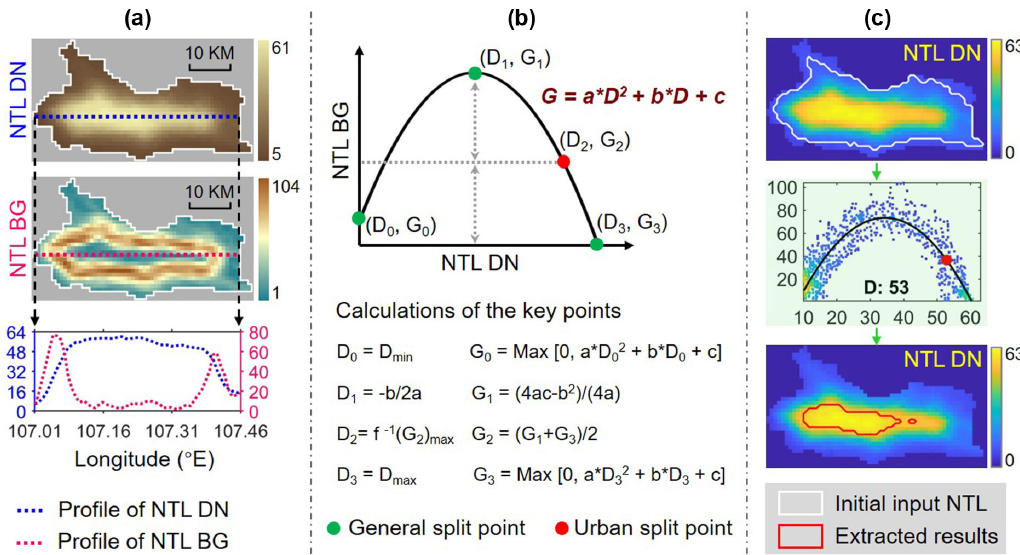
Figure 5. Illustration of the parabola-based strategy. (a) The NTL and corresponding brightness gradient (BG) maps and their profile curves in a latitudinal transect across the urban cluster of Baoji in 2012. (b) A schematic diagram of the parabola-based strategy. (c) An example of mapping urban extents in Baoji in 2012 using the parabola-based strategy. The urban cluster of Baoji in (a) and (c) is a city in the Shaanxi province in China. This cluster exhibits a gradual variation in the NTL spatial gradient in 2012.